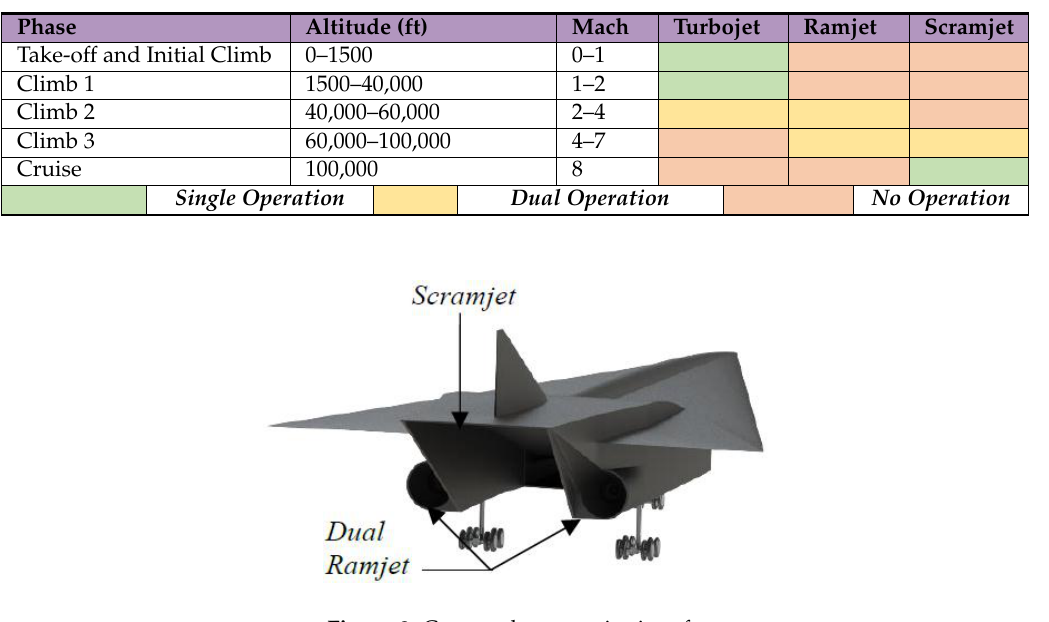
Figure 8. Concept hypersonic aircraft.